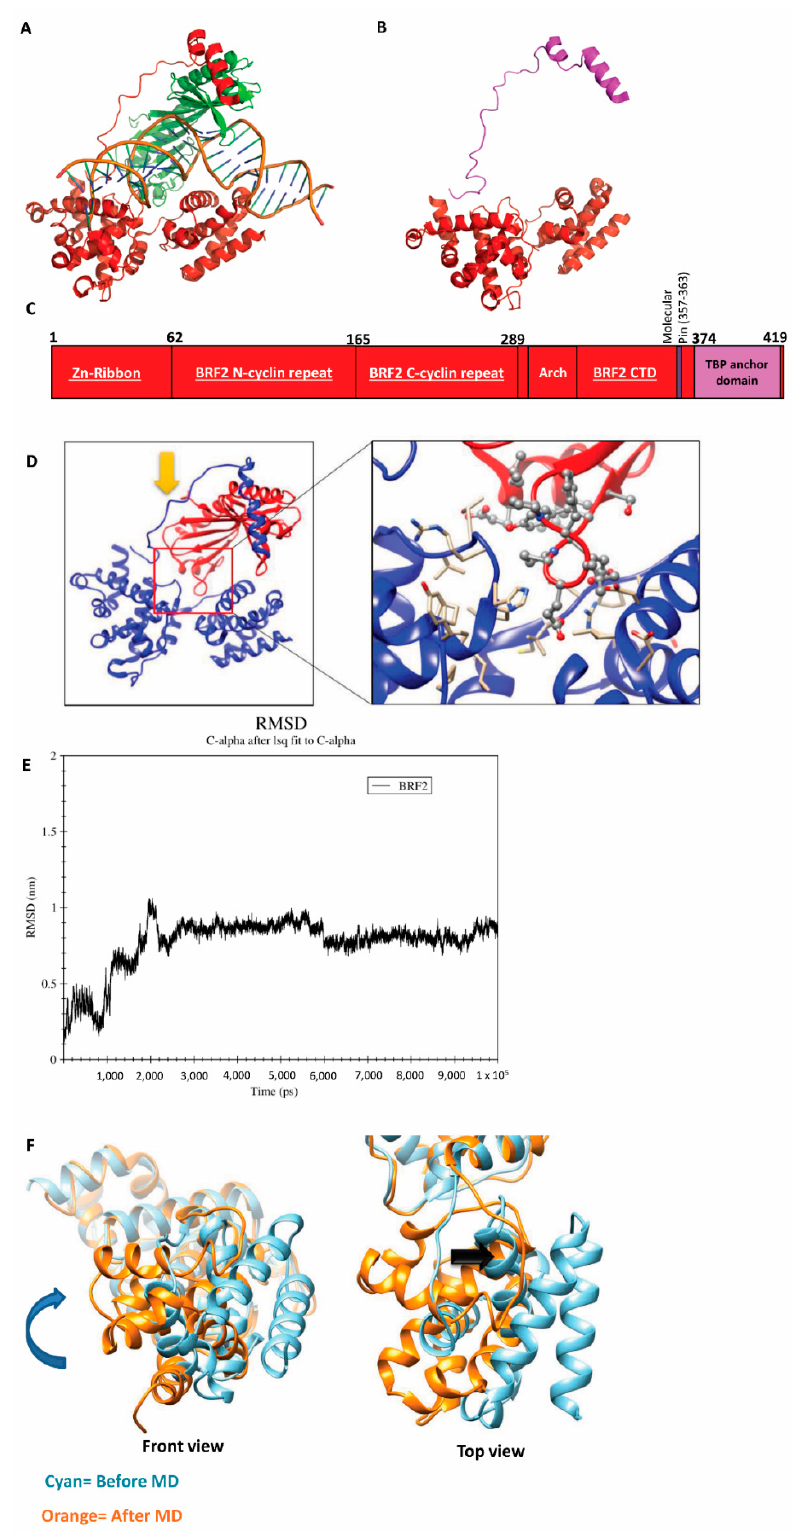
Figure 3. BRF2 structure and conformational changes. ( A )The structure of BRF2 in complex with TBP and DNA. (PDBID: 4ROC). ( B ) The structure of BRF2. (PDBID: 4ROC). ( C ) Schematic representation of BRF2 domains. ( D ) The binding site of TBP on the surface of BRF2 (PDBID: 4ROC). ( E ) RMSD plot of free-BRF2 during the 100 ns MD simulation by means of GROMACS. The Figure depicts a representative image of at least three independent repeats. ( F ) Structural changes of BRF2 at the end of the MD simulation. Cyan: before MD, orange: after MD (see more details in Supplementary Video S1).